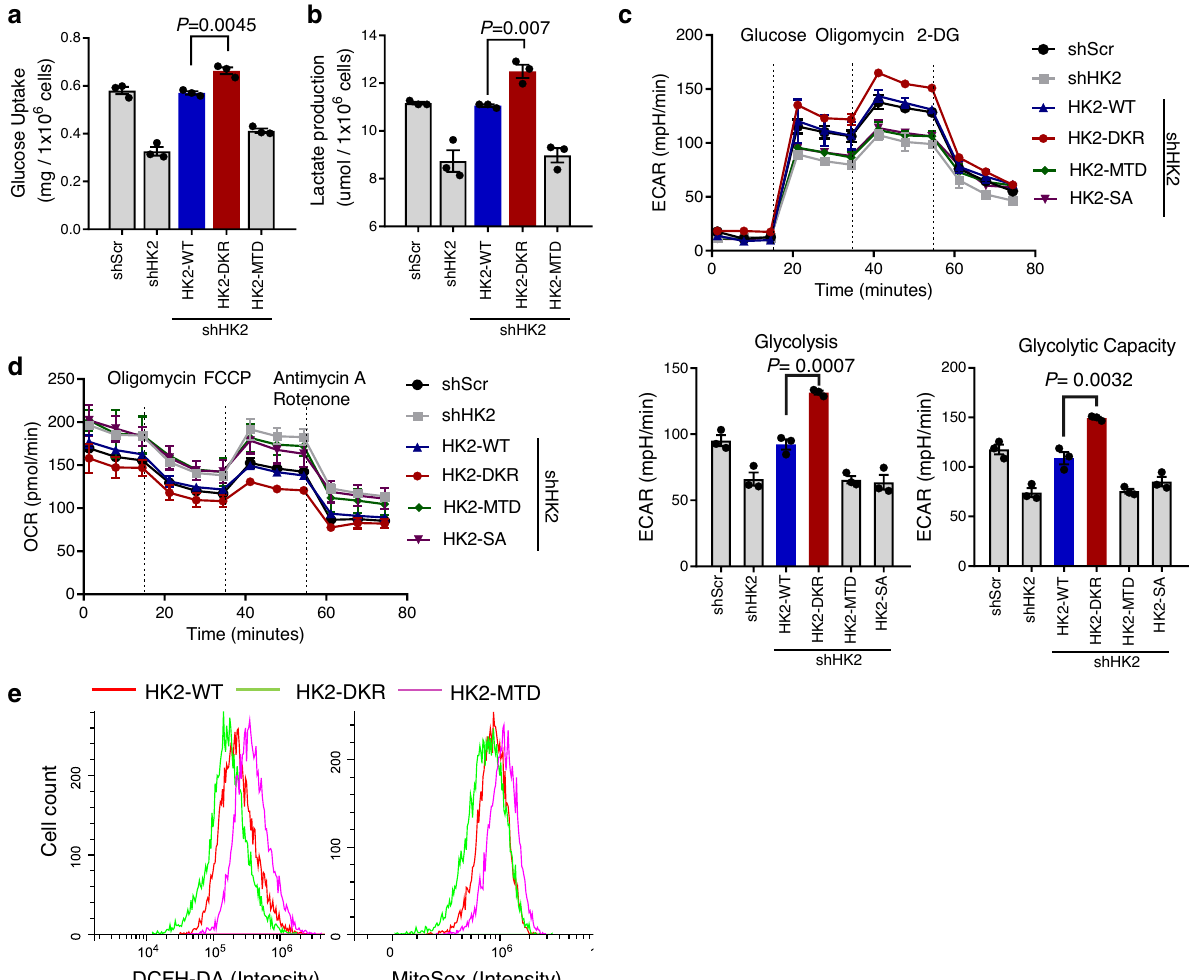
Fig. 3 SUMO-defective HK2 increases prostate cancer cell glycolysis and decreases mitochondrial respiration and ROS. a Glucose consumption was measured in PC3 cells with different mutant forms HK2. Endogenous HK2 was knockdown by shRNA and replaced by different mutant forms with HA tag in PC3 cells. Data are presented as mean ± SEM of three biologically independent samples. Statistical signi fi cance was determined by a two-tailed Student ’ s t test. b Lactate production was measured in PC3 cells with different mutant forms HK2. Data are presented as mean ± SEM of three biologically independent samples. Statistical signi fi cance was determined by a two-tailed Student ’ s t test. c PC3 cells as described were measured by the mitochondrial stress kit to determine extracellular acidi fi cation rate (ECAR). Data are presented as mean ± SEM of three biologically independent samples. Statistical signi fi cance was determined by a two-tailed Student ’ s t test. d PC3 cells as described were measured by the mitochondrial stress kit to determine oxygen consumption rate (OCR). e Intracellular and mitochondrial levels of reactive oxygen species (ROS) were measured in indicated PC3 cells by fl ow cytometry. Left: PC3 with the different mutant form of HK2 was loaded with ROS probe DCFH-DA, and DCF fl uorescent intensity was measured by fl ow cytometry. Right: Cells labeled with MitoTrackerTM Red CMXRos were measured by fl ow cytometry to see the mitochondrial level of ROS. Experiments were performed at least twice in triplicates. Source data are provided as a Source Data fi